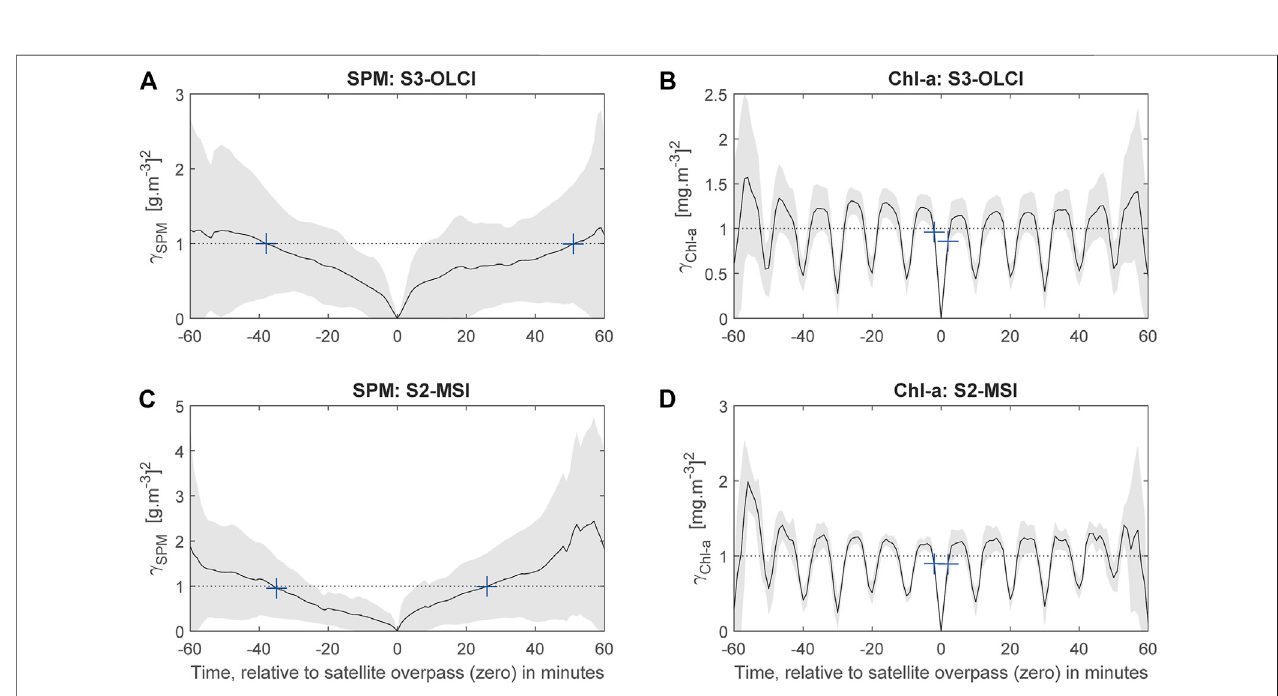
Frontiers in Remote Sensing |